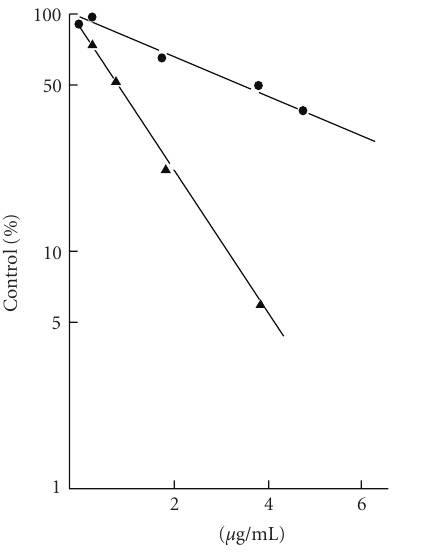
Figure 12: E ff ect of berberine on the incorporation of thymine [ 3 H] into DNA (- • -) and glycine [ 13 C] into protein (- (cid:2) -) by sarcoma S180 cancer cells in vitro. Reprinted from Creasey [80] with permission from Elsevier.